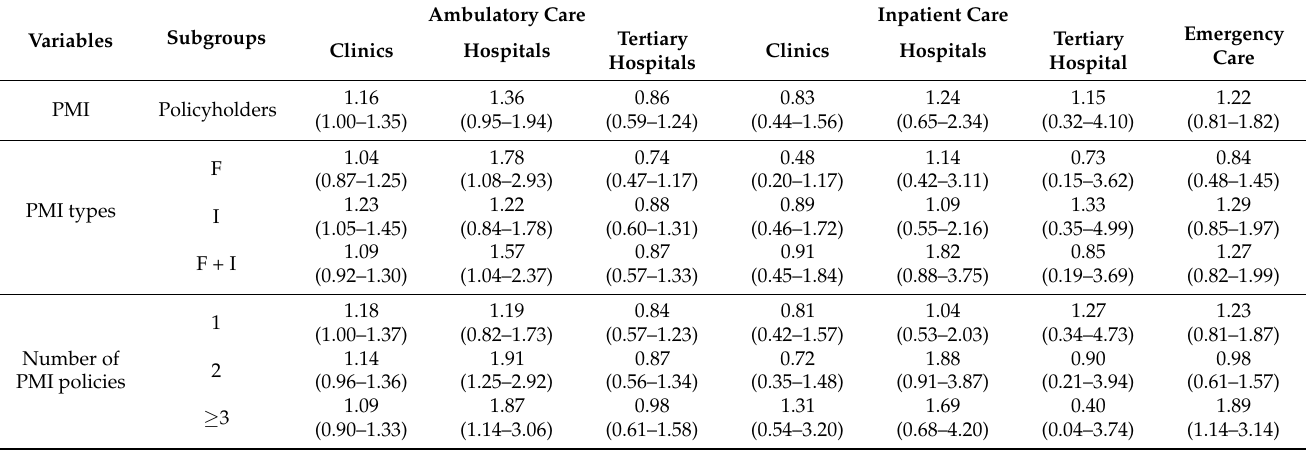
Table 3. Association of private medical insurance and health care participation (reference =